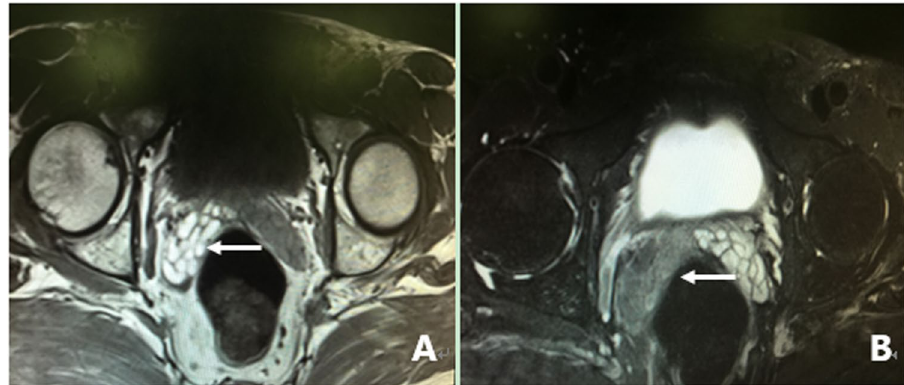
Figure 1. MRI image of a fresh hemorrhage in the right side of the SV. ( A ) This image shows high signal intensity in the right SV and low signal intensity in the left SV on T1WI. ( B ) This image shows low signal intensity in the right SV and high signal intensity in the left SV on T2WI. This pattern suggests that a fresh hemorrhage is present in the right SV.